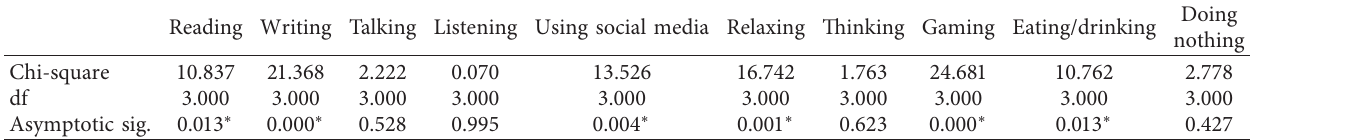
Table 18: Kruskal–Wallis test statistics and the rankings of income